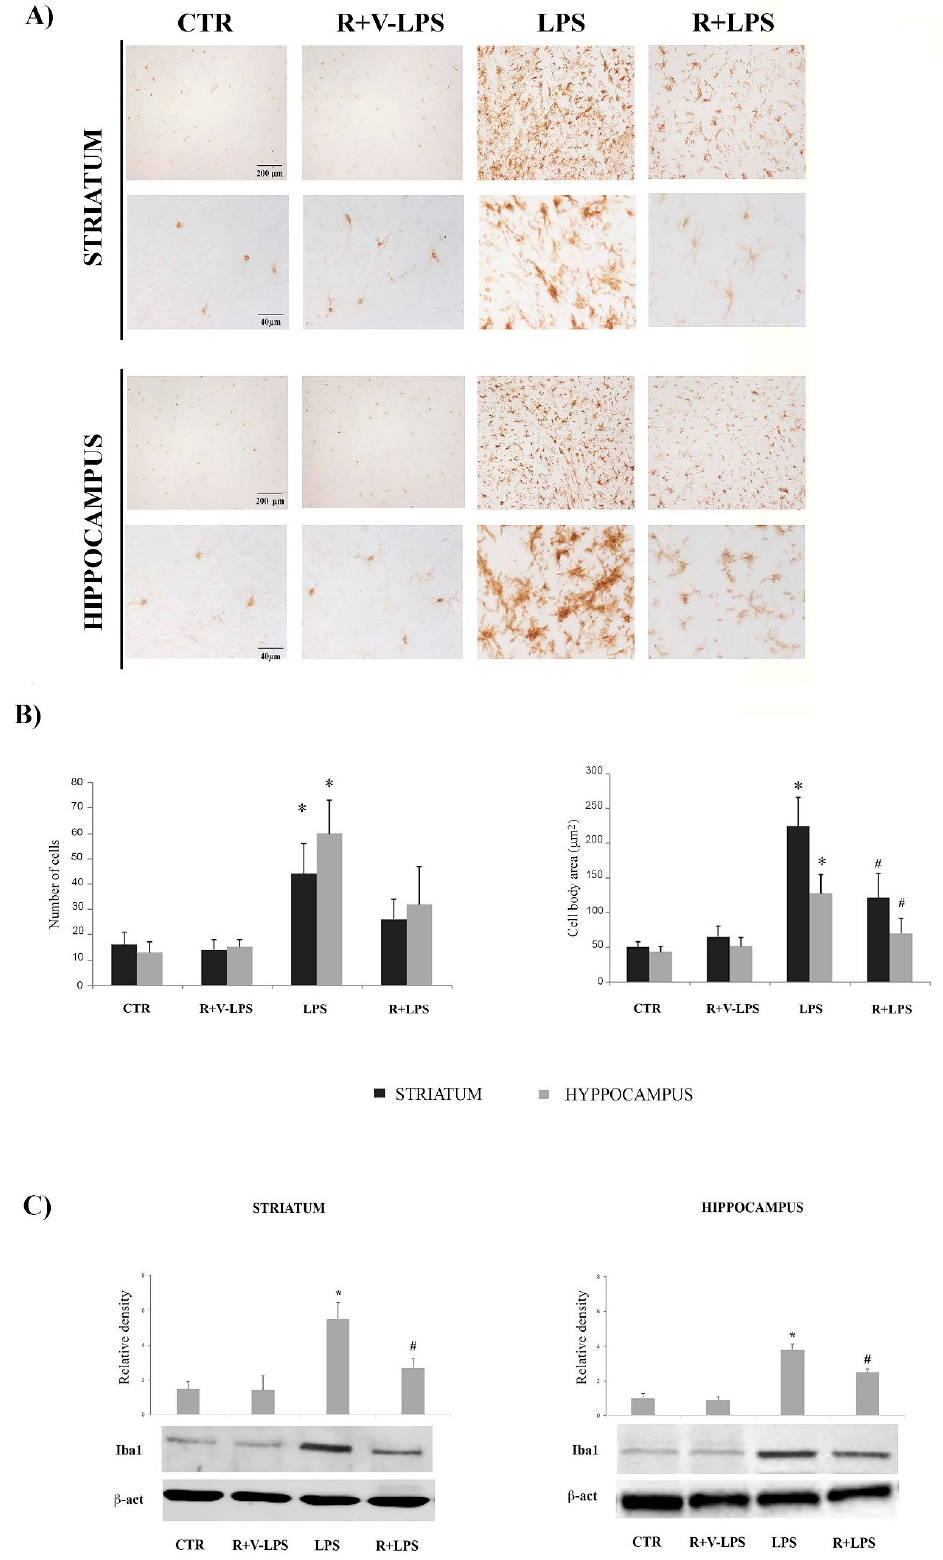
Figure 2. ( A ) Iba1 immunoreactive cells in the striatum (upper) and hippocampus (lower) in untreated mice (CTR), resveratrol and LPS vehicle (R+V-LPS)-treated mice, LPS-treated mice (LPS) and resveratrol plus LPS treated mice (R+LPS). ( B ) Number (per field, left) and cell body area (right) of Iba1 immunoreactive cells in untreated controls mice (CTR),